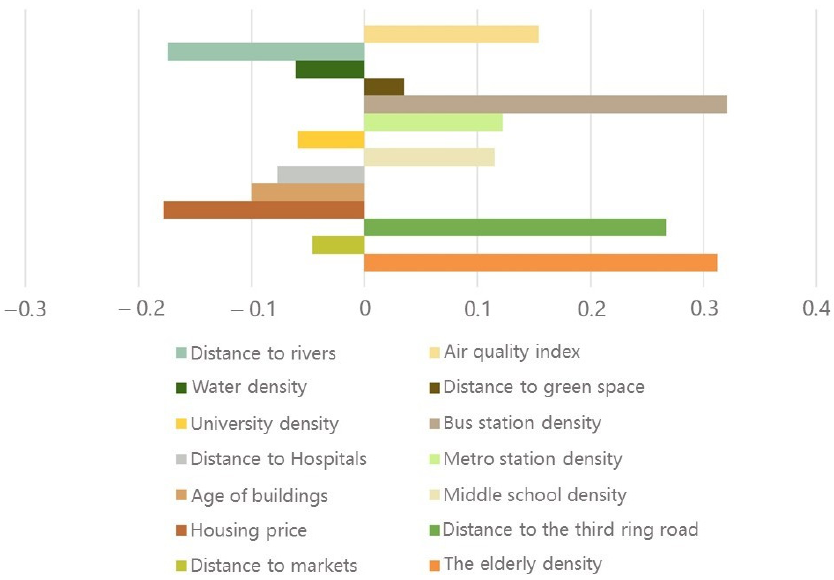
Figure 5. Statistics chart of standardized coefficients.